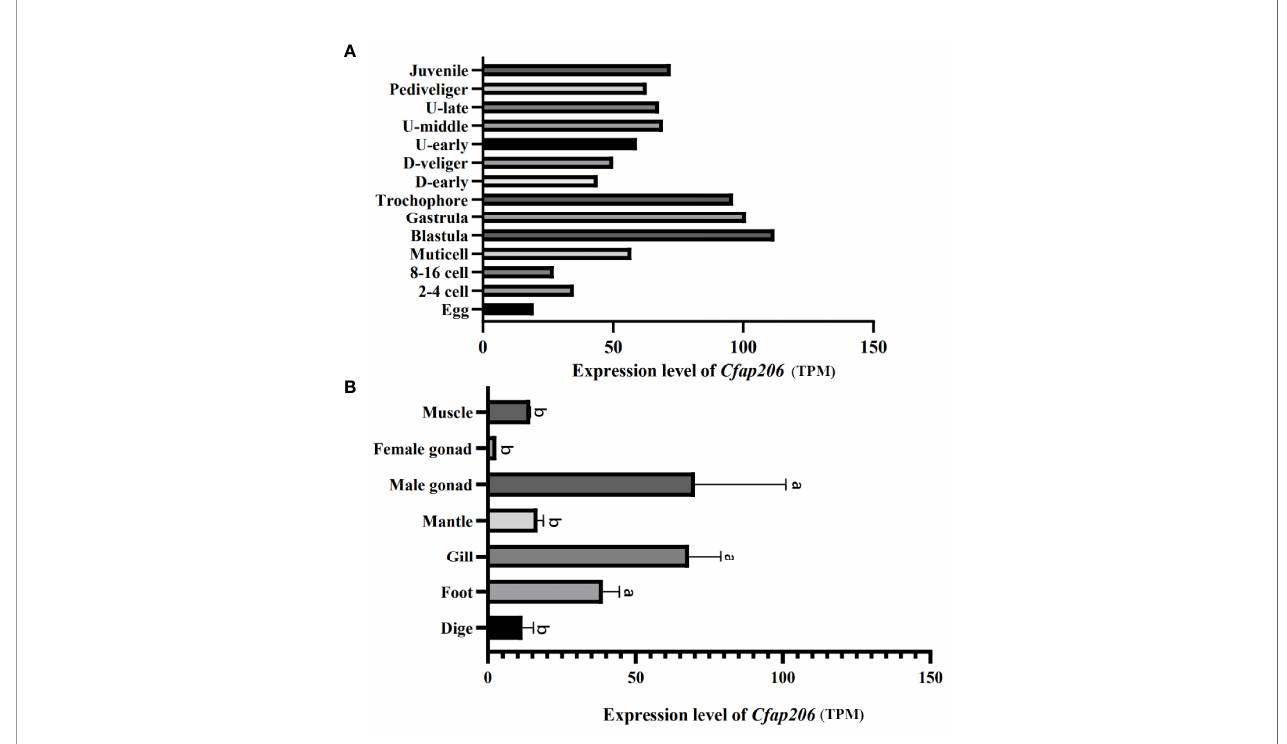
FIGURE 2 | Spatiotemporal expression of Cfap206 in M. lateralis . (A) The expression of Cfap206 in fourteen embryonic stages. (B) The expression of Cfap206 in seven tissues. SPSS28.0 was used for one-way ANOVA analysis of the data, and Duncan method was used to test the signi fi cance of the difference between the values of each